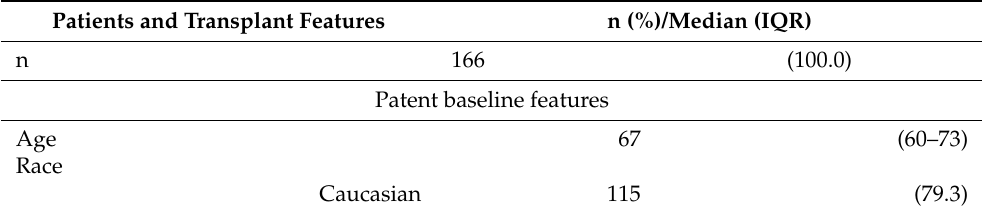
Table 1. Patients and kidney transplant baseline